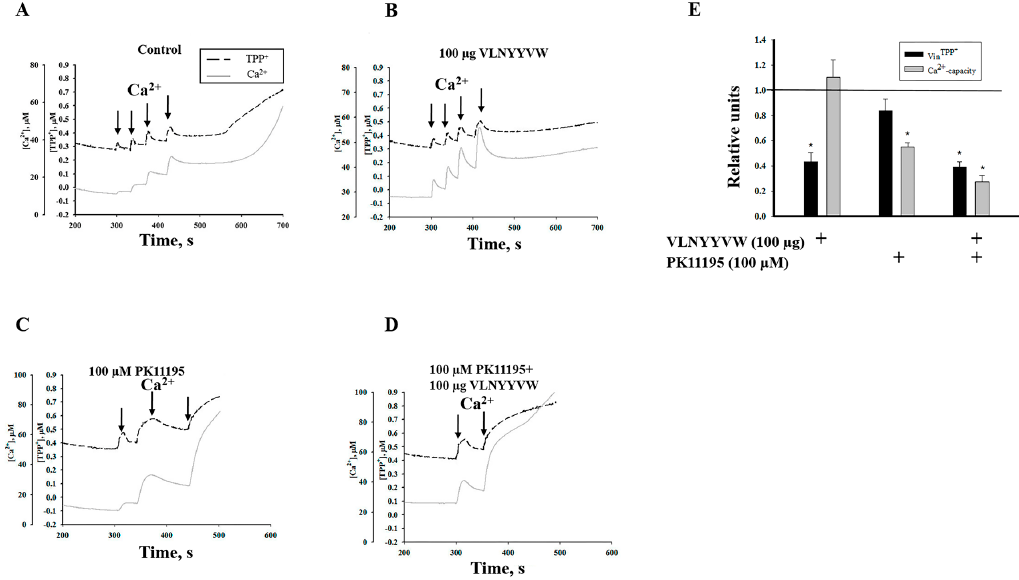
Figure 1. Effect of the VLNYYVW peptide and the translocator protein (TSPO) ligand, PK 11195, on Ca 2+ ‐ induced mPTP opening in RBM (rat brain non ‐ synaptic mitochondria). The arrows indicate where CaCl 2 (50 µM) was added to the mitochondrial suspension. RBM were incubated in standard medium, as described in Materials and Methods. A value of p < 0.05 was considered to be significant (asterisk indicates p < 0.05). ( A ) Control RBM; ( B ) VLNYYVW (100 µg) ‐ treated RBM; ( C ) PK 11195 (100 µM) ‐ treated RBM; ( D ) The combined effect of VLNYYVW and PK 11195; ( E ) The quantitative characteristics of mitochondrial parameters. Ca 2+ capacity and the rate of TPP+ influx, calculated as